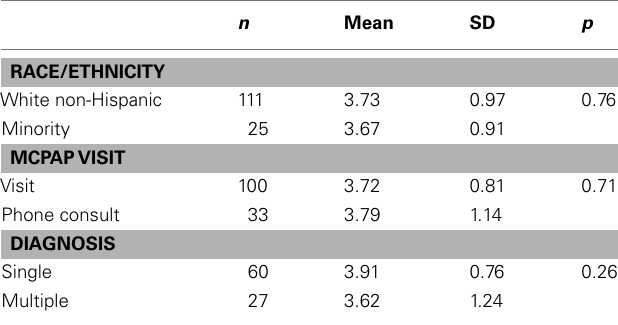
Table 3 | Mean satisfaction scores by minority status, visit status, and co-morbidity